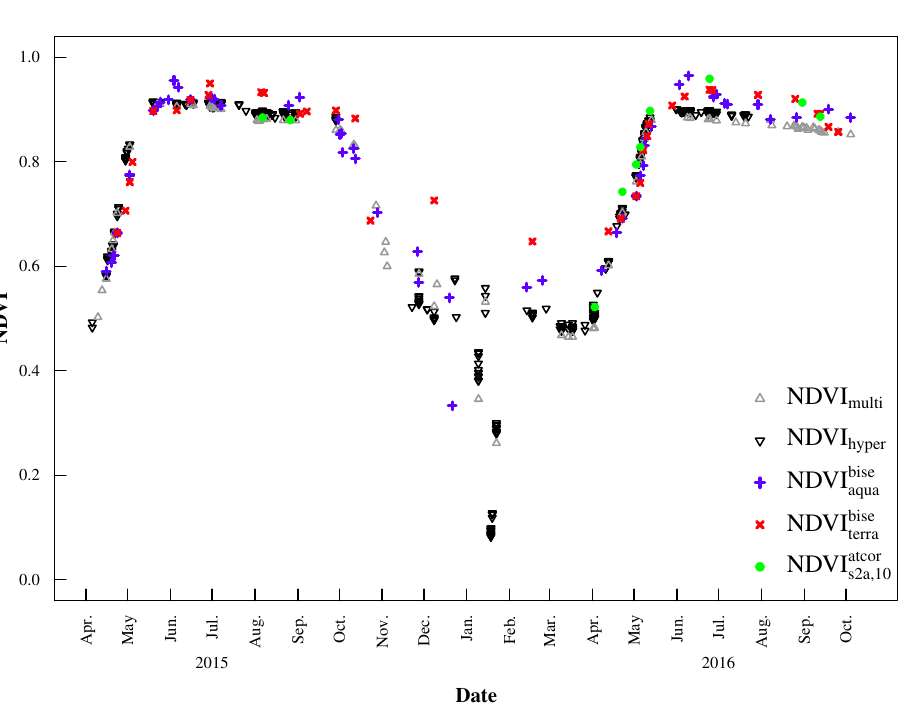
Figure 4. NDVI time series derived from the hyperspectral sensor system ( NDVI hyper , black triangles), multispectral sensor system ( NDVI multi , grey triangles), MODIS Aqua ( NDVI bise aqua , blue plus signs) and Terra ( NDVI bise terra , red crosses), as well as Sentinel-2A (10 m, Bands 4 and 8) processed with ATCOR 2/3 ( NDVI atcor , green filled s2a , 10